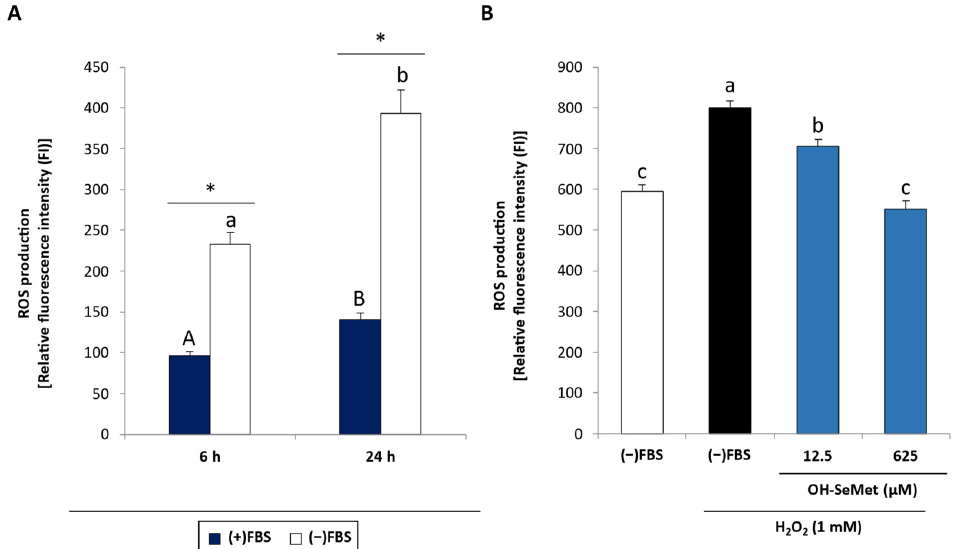
Figure 4. ROS production in ( A ) macrophages cultured in (+)FBS or ( − )FBS for 6 or 24 h and ( B ) macrophages supplemented with 12.5 and 625 μ M OH-SeMet for an additional 72 h and then stimulated with 1 mM H 2 O 2 for 4 h. ROS production is shown as relative fluorescence intensity (FI) obtained at the beginning of the experiment ((FI f × 100)/FI i ). The results are expressed as mean ± SEM of n = 9 cultures. The asterisk (*) denotes significant differences ( p < 0.05) between (+)FBS and ( − )FBS ( A ) and different letters denote differences ( p < 0.05) between incubation periods ( A ) and conditions ( B ).